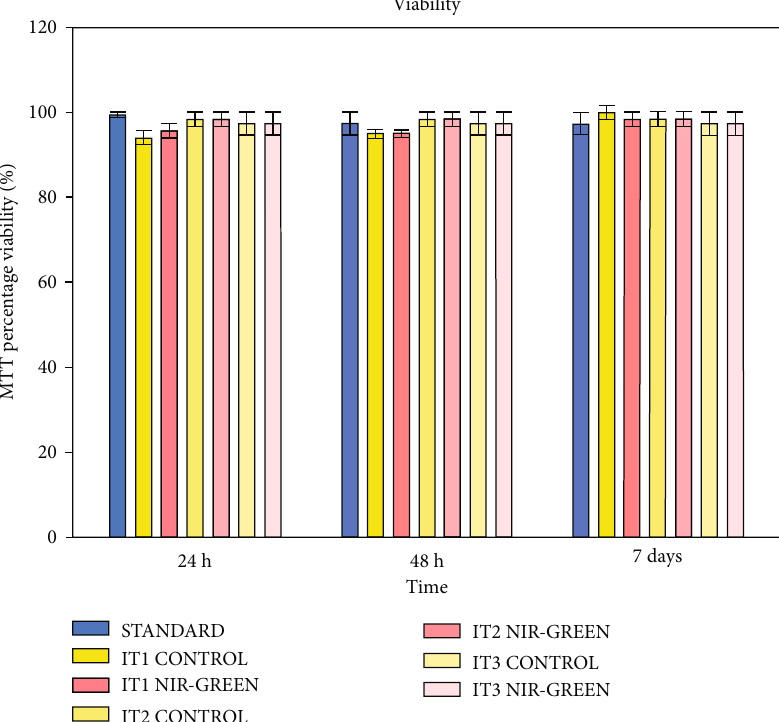
Figure 8: Cell viability studies of transdi ff erentiated iADSCs 24 h, 48, and 7 days post-PBM. MTT assay percentage viability. All cells maintained high viability, and no signi fi cant increases or decreases were recorded.